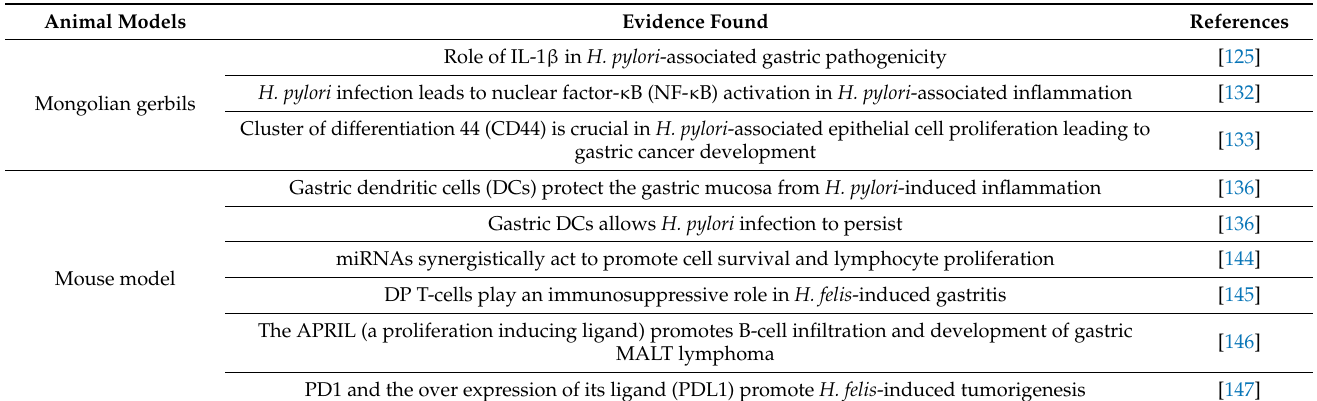
Table 3. Animal models showing the role of host factors in H. pylori -associated gastric pathogenicity. Animal Models